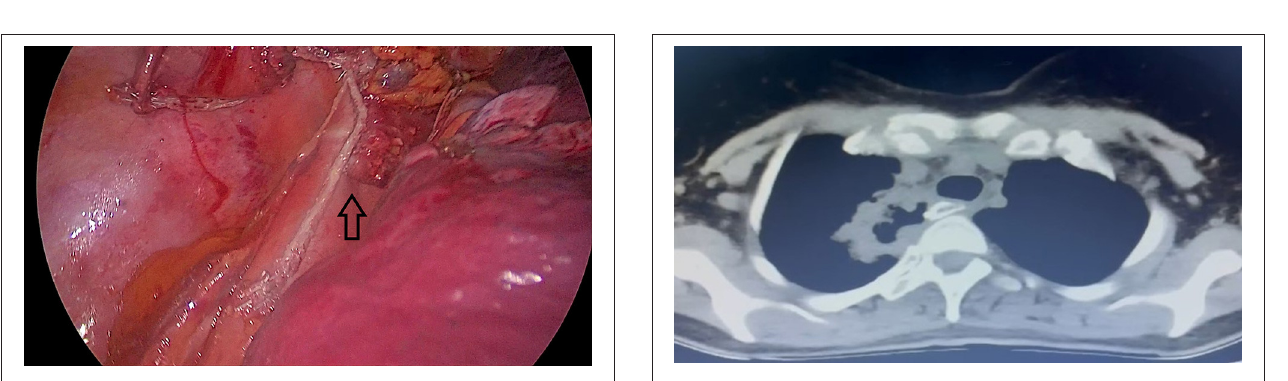
FIGURE 4 | Misalignment of the stomach and esophageal walls (black arrow). This patient had a late leak and left main bronchial fistula that healed in 6 months after double stenting of the trachea and the esophagus.